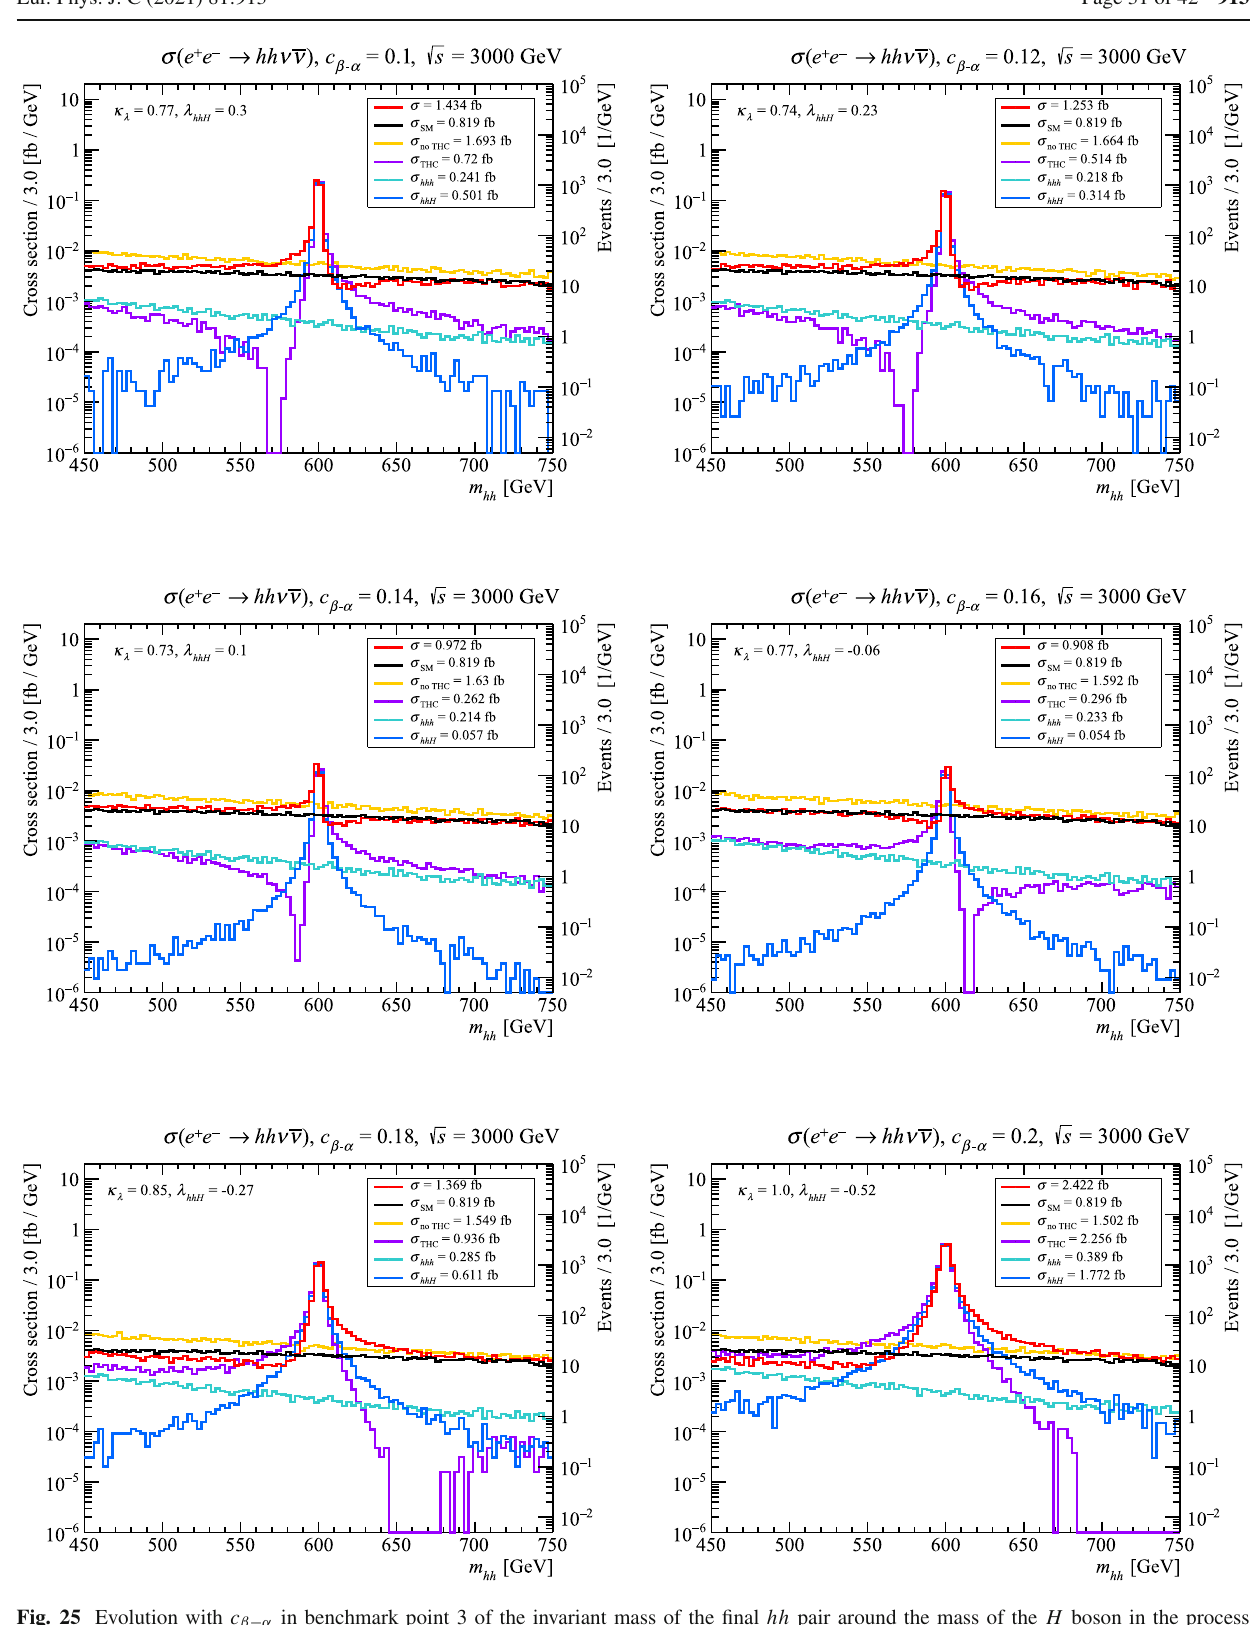
Fig. 25 Evolution with c β − α in benchmark point 3 of the invariant mass of the final hh pair around the mass of the H boson in the process √ e + e − → hh ν ¯ ν at s = 3000